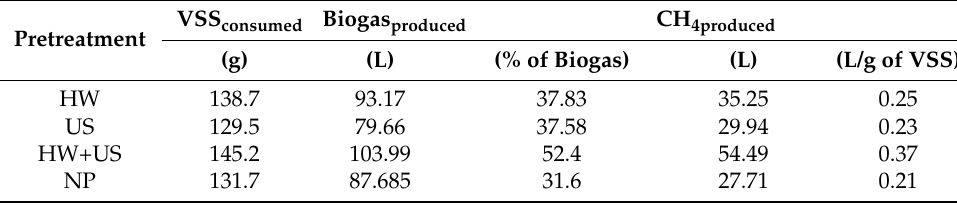
Table 3. Production of methane by each treatment with different pretreatments.